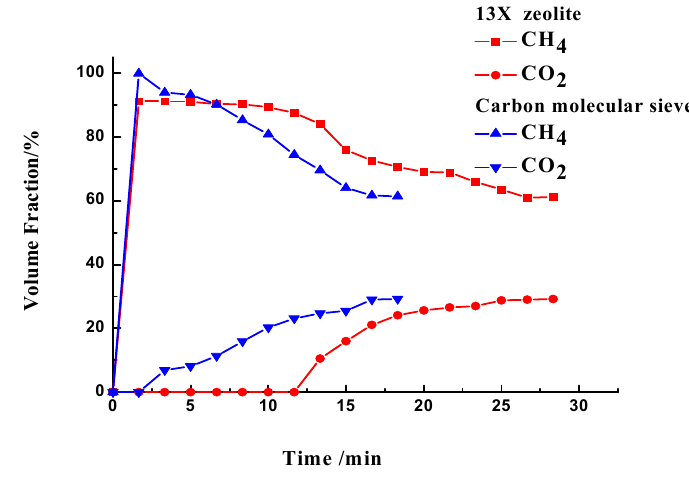
Figure 6. Breakthrough curves of CH 4 and CO 2 in dry desulfurized biogas at 25 ◦ C and 0.2